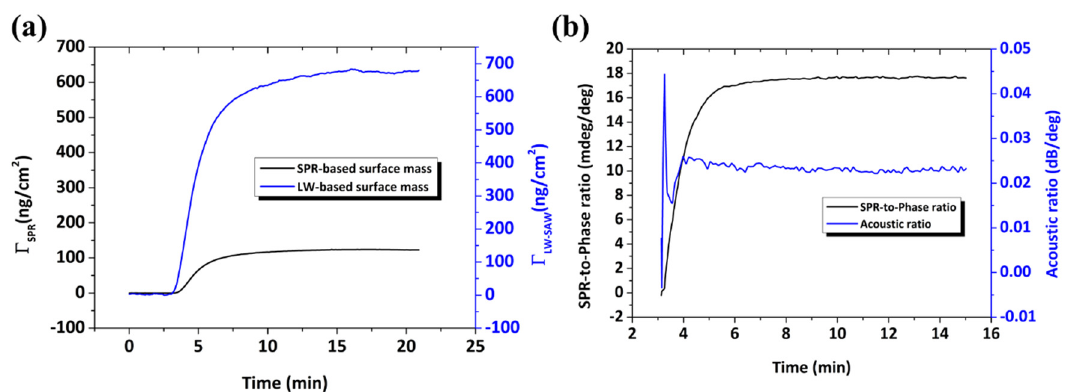
Figure 16. ( a ) Real-time BSA mass uptake estimated by means of phase and SPR response. ( b ) Real-time ratios between SPR-phase and amplitude–phase responses.